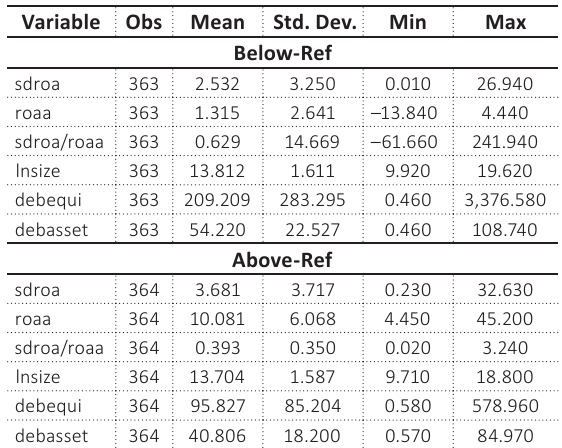
Table 1. Statistics of two groups of companies classified based on market reference points